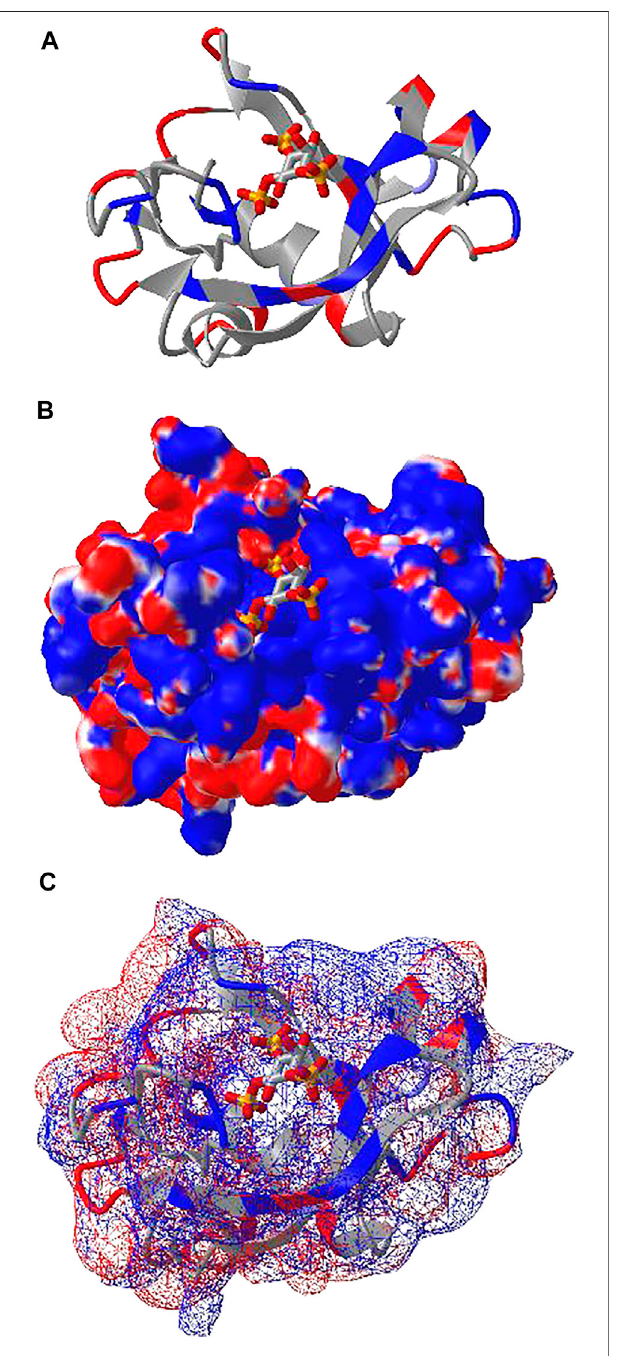
FIGURE 4 | DelPhi electrostatic potential of membrane-binding PH domain(PDB1MAI). (A) ThePHdomainisshowninribbonstylewithpositively and negatively charged residues colored in blue and red respectively. IP 3 is shown in stick style with three phosphate groups. (B) The electrostatic potential of the PH domain is shown on the surface. Blue indicates greater than +50 mV and red indicates less than − 50 mV. Sharable link: https:// structure.ncbi.nlm.nih.gov/icn3d/share.html?5hvduy8LQHtJ1NdL6. (C) The equipotential map of the PH domain. The blue and red meshes indicate +50 and − 50 mV potential pro fi le,